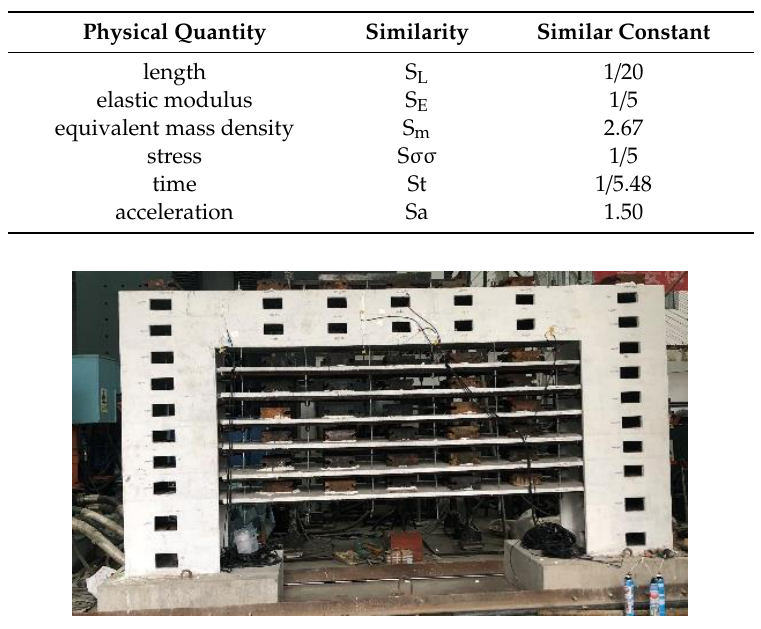
Table 3. Similitude ratios of experimental model.